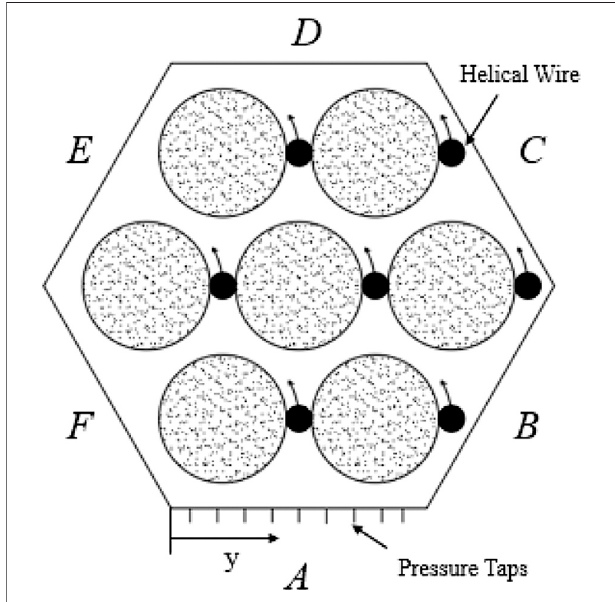
FIGURE 5 | Cross section for the 7-pin wire-wrapped fuel